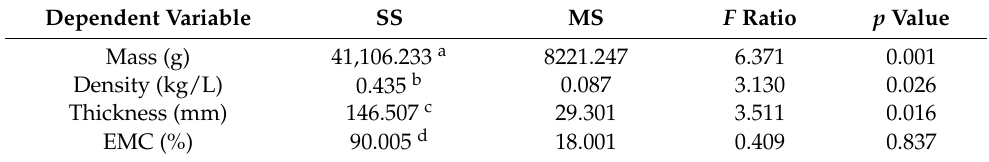
Table 1. ANOVA test results on mass, density, thickness, and EMC.